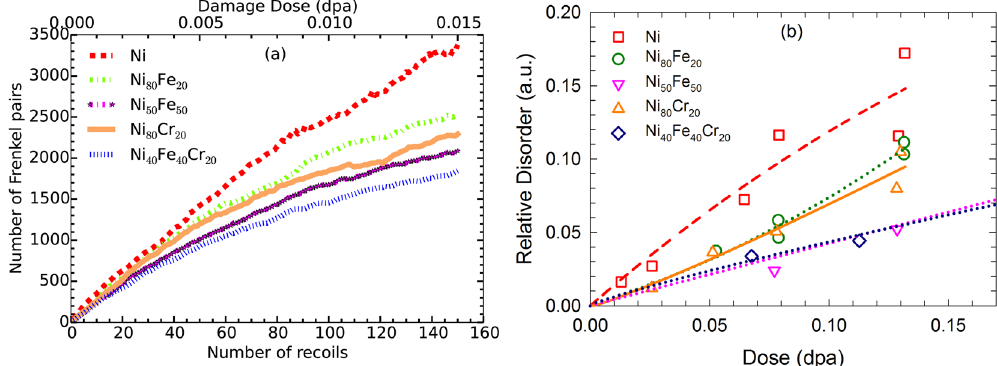
Figure 2. Comparison of damage accumulation. Damage accumulation in pure Ni, Ni 80 Fe 20 , Ni 50 Fe 50 , Ni 80 Cr 20 and Ni 40 Fe 40 Cr 20 alloys from both irradiation simulation and experiment. ( a ) Accumulation of point defects with increasing numbers of cumulative recoils and the corresponding dose in dpa. This is an average of two sets of cumulative recoil simulations. ( b ) Relative disorder in the model systems as the function of dose at damage peak (~400